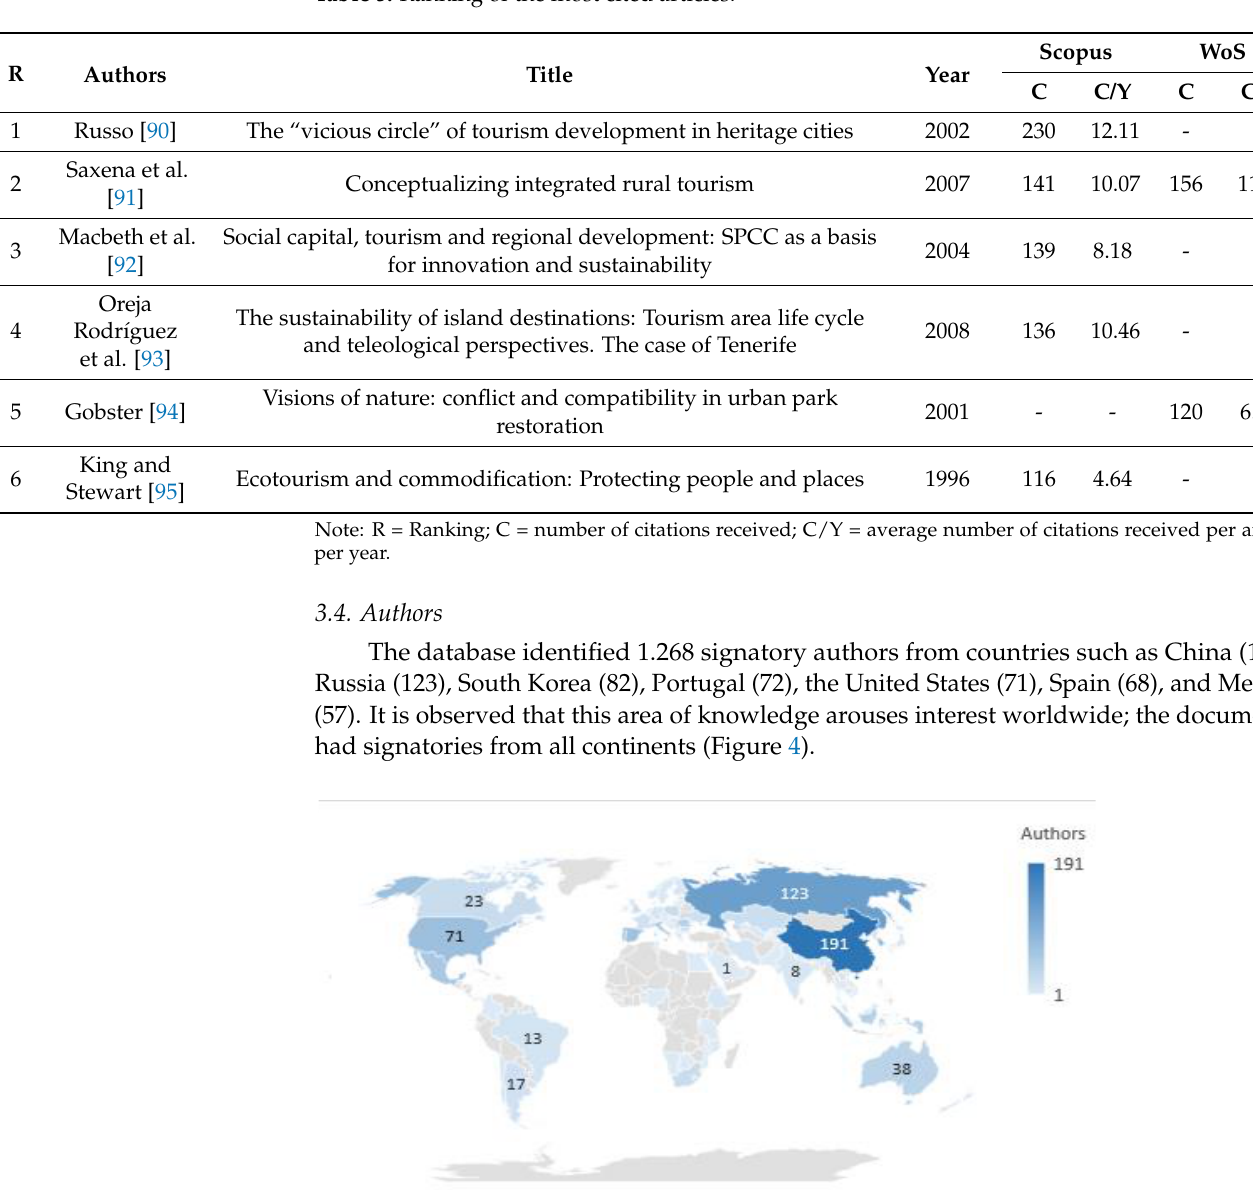
Figure 3. Distribution of citations by articles. Source: Authors’ own data. Table 5. Ranking of the most cited articles.